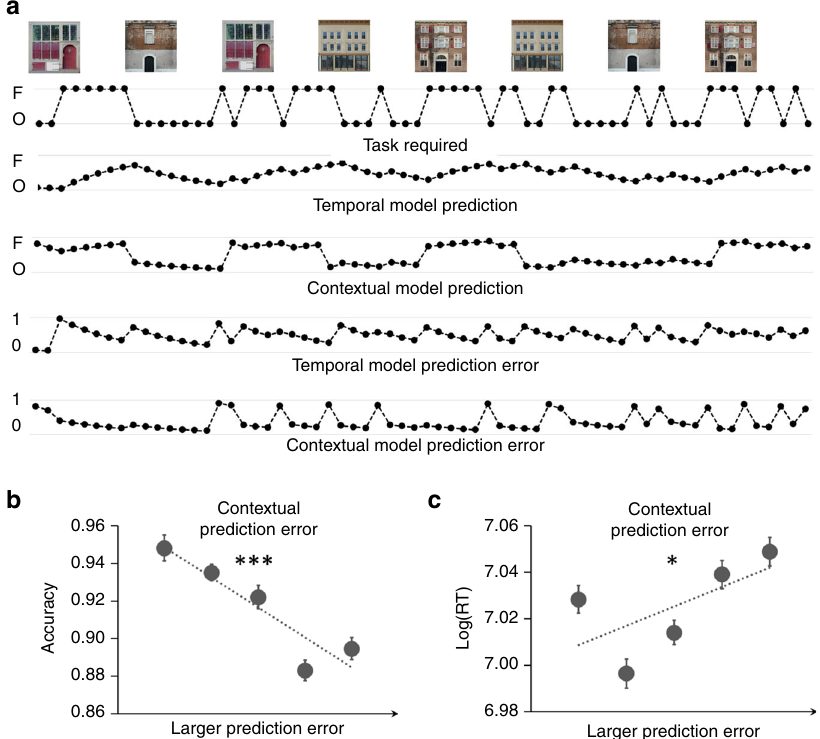
Fig. 3 Behavioral analyses and results. a Time courses of reinforcement learning model outputs for an example run. The building images mark the beginning of blocks. Each dot represents one trial. Note that contextual model predictions are more sensitive to change of contexts than temporal model predictions. b , c Quintiles ( x -axis) and mean ± SEM of group-level accuracy ( b ) and logged RT ( c ), plotted as a function of contextual model prediction error. * p < 0.05, *** p < 0.001 (two sided one-sample t -tests). The experiment was conducted once ( n = 33 biologically independent samples). P values are uncorrected. Source data are provided as a Source Data fi